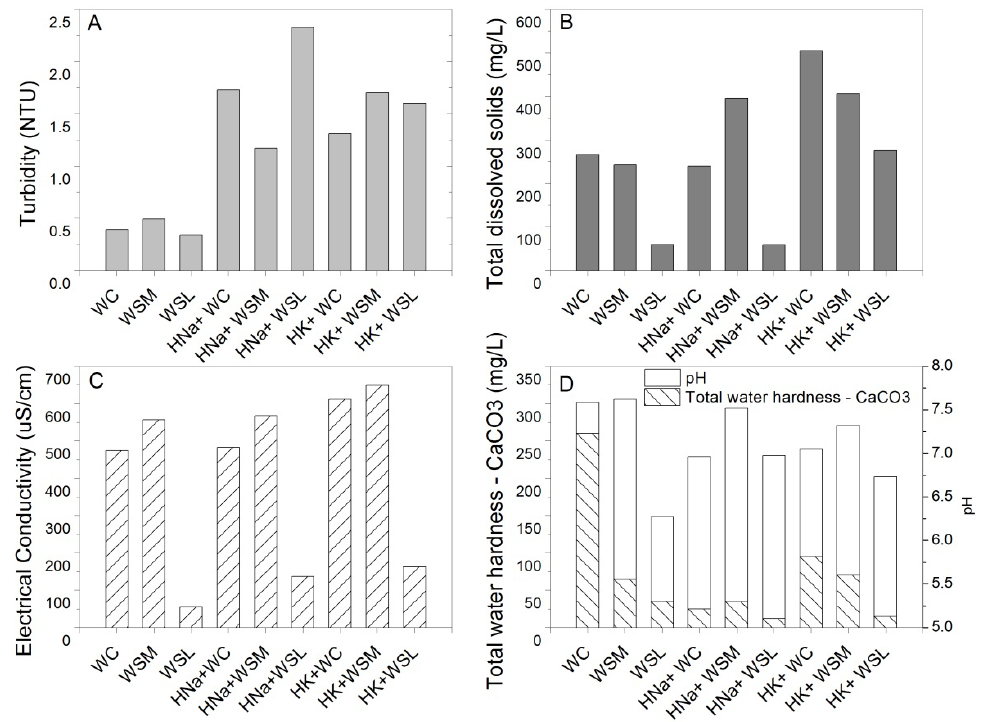
Figure 5. Physical properties comparison of the types of waters before and after the swelling process. ( A ) Turbidity. ( B ) Total dissolved solids. ( C ) Electrical conductivity. ( D ) Total water hardness—pH.